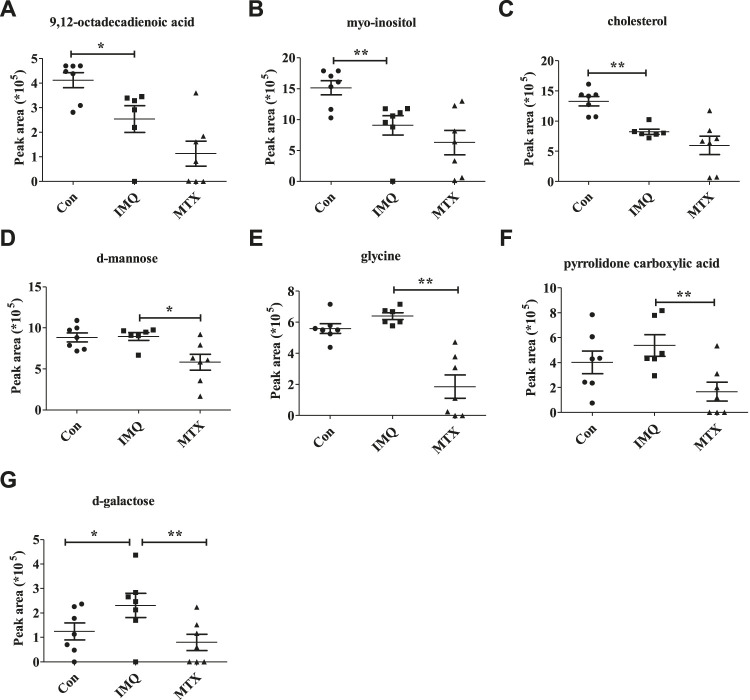
Venn diagrams (A) and heat maps (B) of identified differential metabolites among the control group, IMQ group, and MTX group.